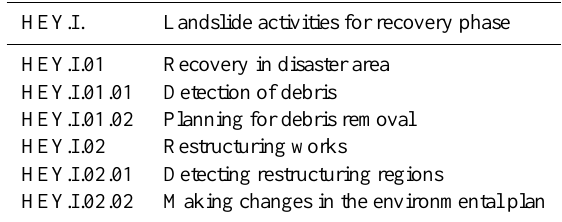
Table 4. Landslide activities for the recovery phase.